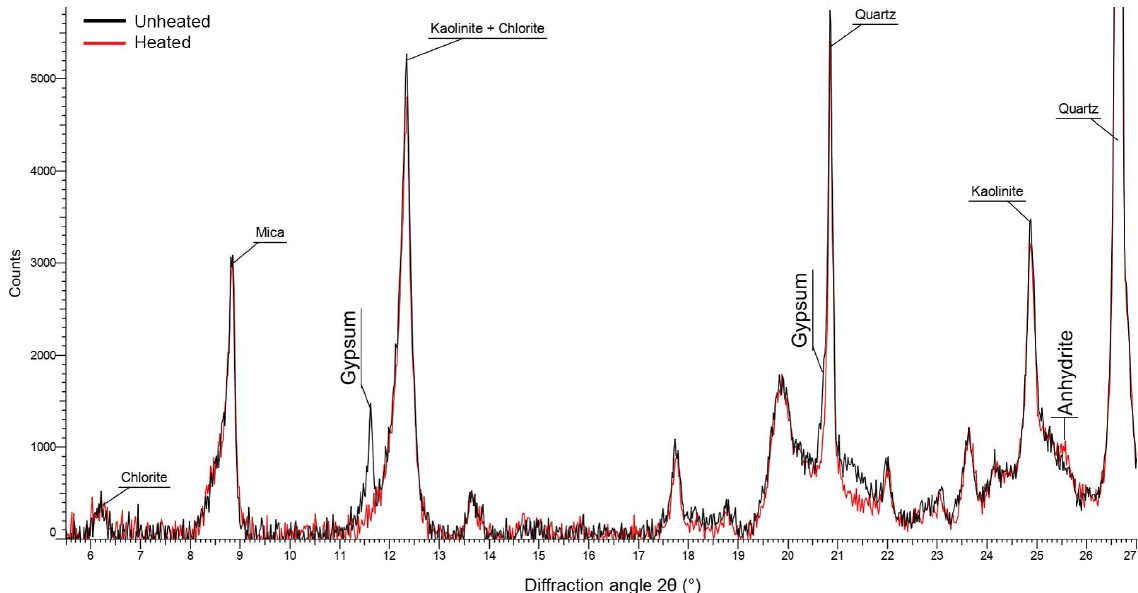
Figure 7. XRD diffractogram of unheated and heated Tenerife2014_1 sample. Vertical text indicates changes in peak height which were used to identify the decrease in gypsum and increase in anhydrite with heating. Horizontal text indicates peaks associated with other minerals in the